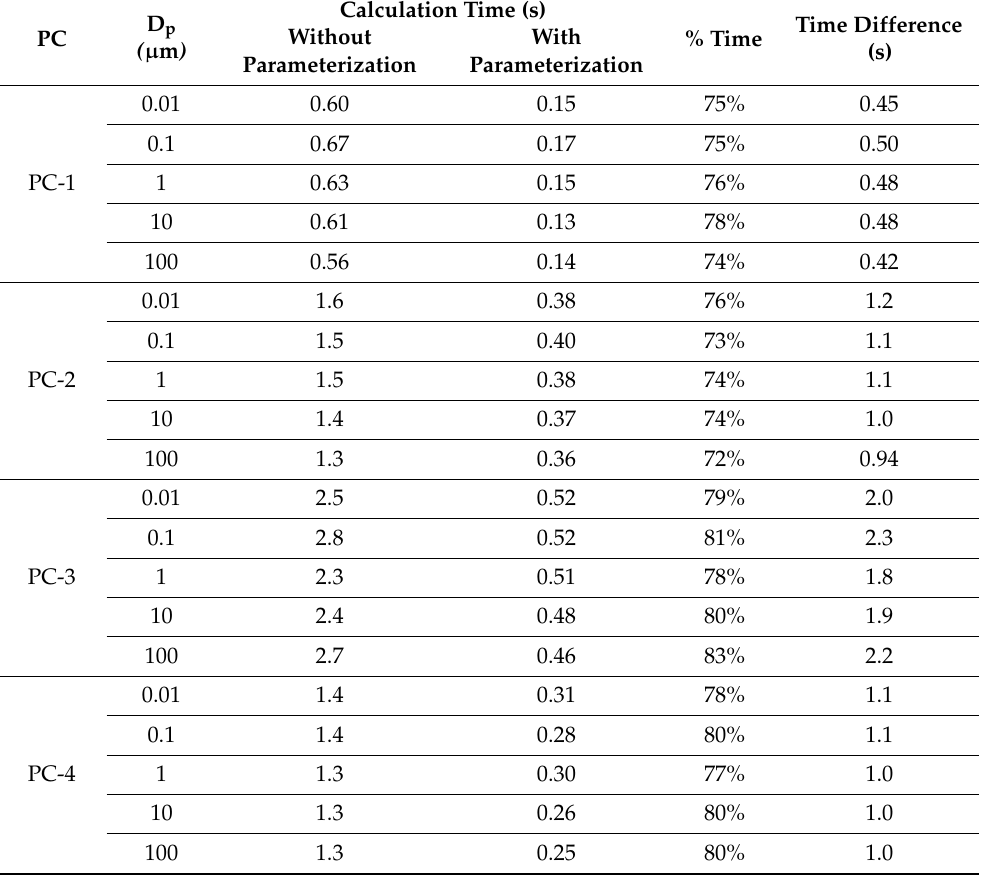
Table 2. A comparison between computation time for unoptimized code (without parameterization) and optimized one (with parameterization). for four computers for a selected particle diameters ( D p ) for friction velocity u* = 0.01 m/s. D p PC ( µ m